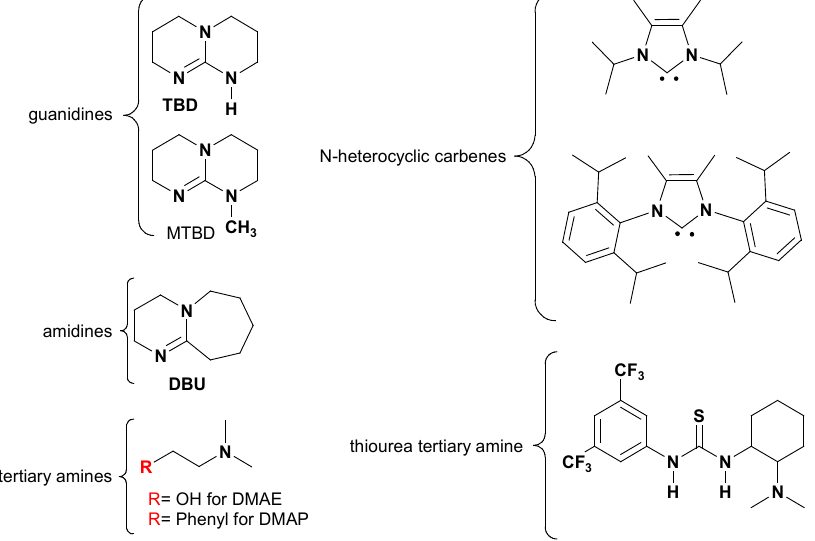
Figure 10. Organic bases used as catalysts in ring‐opening polymerization. The polymers that were synthesized were isolated by precipitation; they had molecular weights up to 50 KDa and a polydispersity index (PDI) of 1.08. The presence or the absence of organocatalyst residues in the final product was not reported. Benzyl alcohol